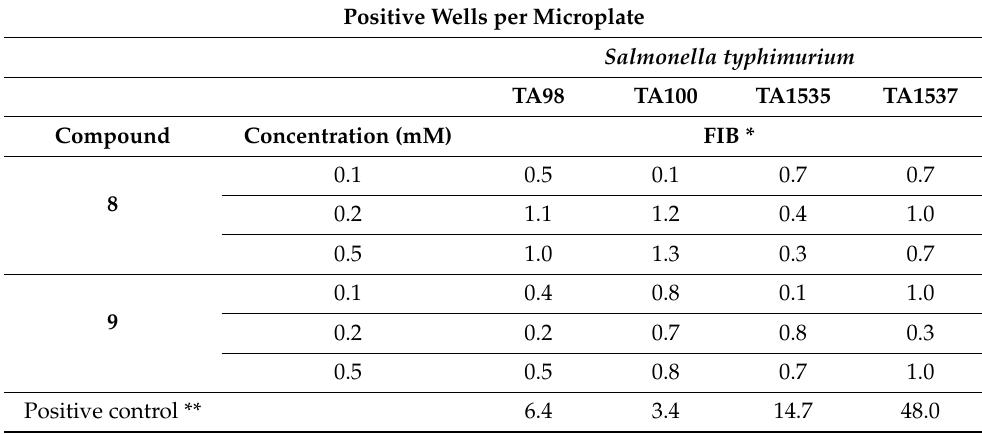
Positive control